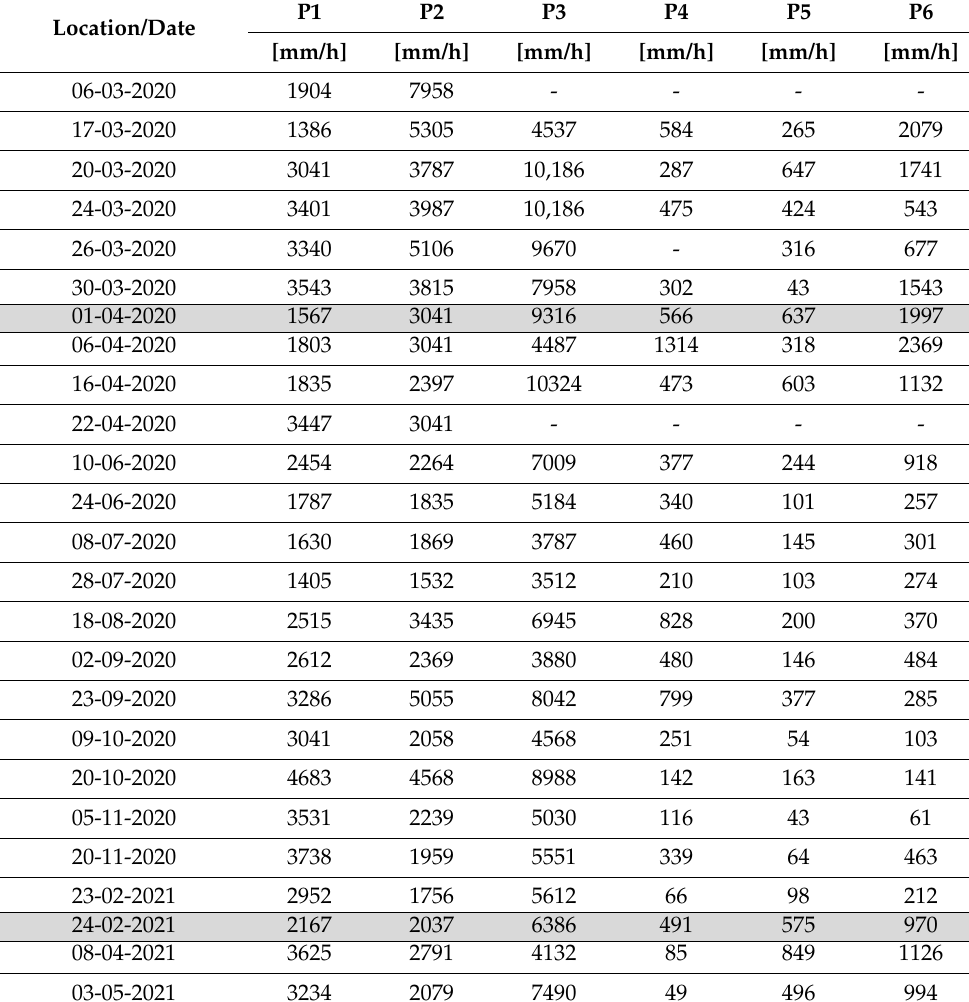
Table 2. Calculated infiltration capacity from the ASTM method (Equation